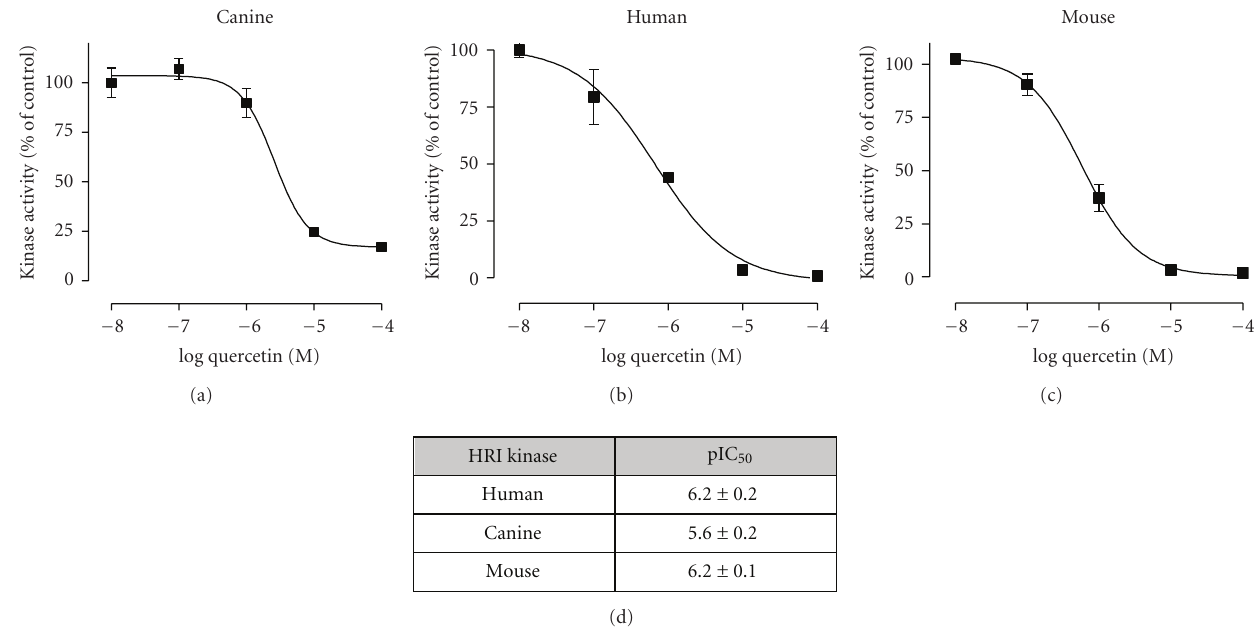
Figure 5: Inhibition of HRI kinase activity by quercetin. The kinase activity of the purified human, mouse and canine HRI proteins was determined using an in-vitro kinase assay in the presence of various concentrations of quercetin from 0.01 μ M to 100 μ M, shown in log M units. The data are expressed as a percent of activity compared to a vehicle control at 100% at the end of the two hour reaction. All experiments were performed in duplicate or triplicate with the mean ± SEM represented.